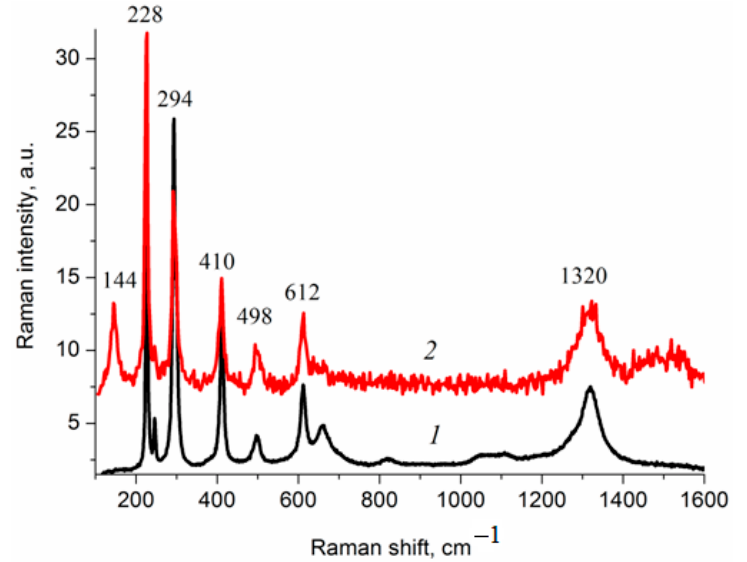
Figure 2. Raman spectra of photoanode samples: (1) Fe 2 O 3 /FTO; (2) Ti 4+ /Fe 2 O 3 /FTO. The curves are displaced vertically for clarity.